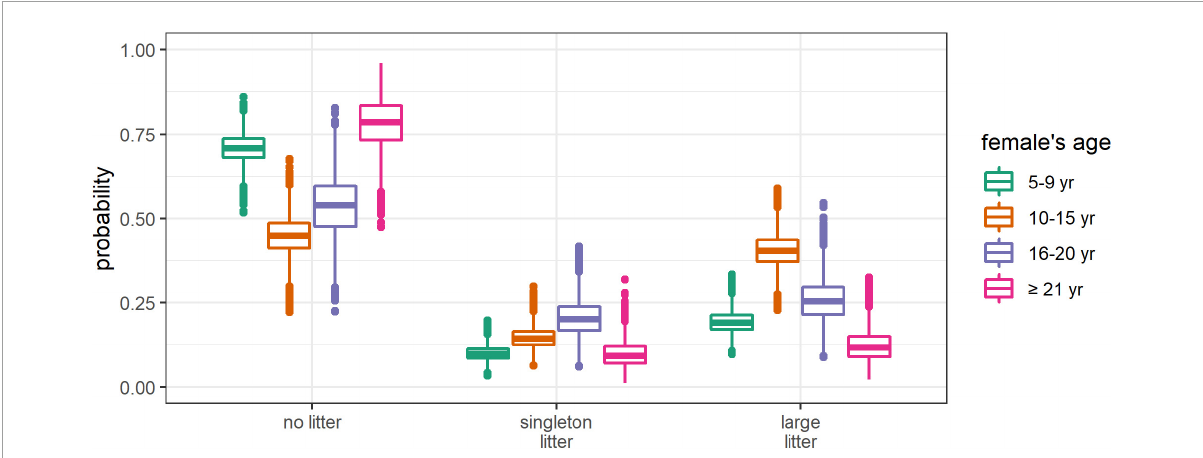
FIGURE3 Posterior distributions of the absolute probabilities of having no litter, a singleton litter, or a large litter, depending on female’s age. All the other covariates were set at their mean value ( DateCapture = 104, i.e., April 14, Size = 195 cm, DateBreakUp = 174, i.e., June 23, WinterAO = –0.06, PriorWinterAO = 0.01, PriorSpringAO = 0.12).